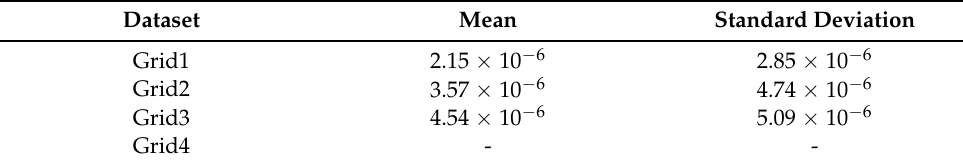
Table 5. The accuracy metrics of the Spark-based